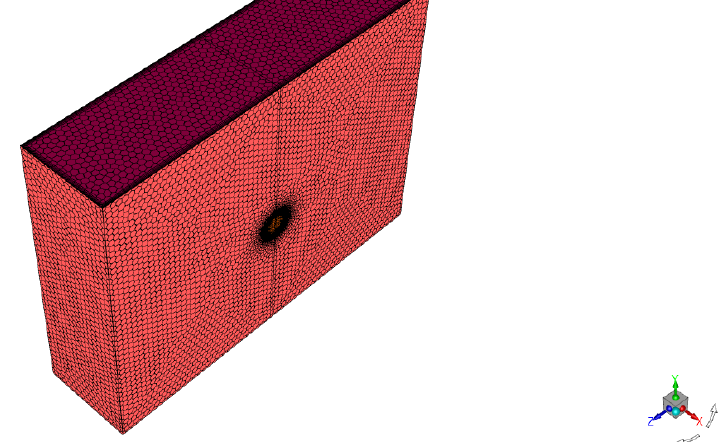
Figure 6. Mesh model.